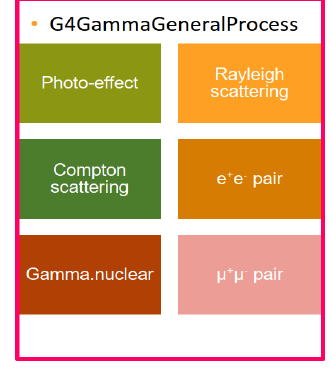
Fig. 1. General process for gamma includes 6 different Geant4